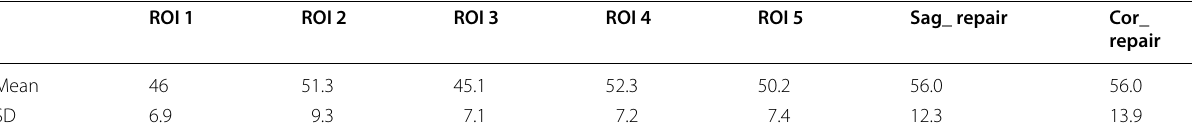
Mean T2 values with corresponding standard deviations (SD) for native and repair tissue. Mean values for each region of interest (ROI) are calculated from the first measurements of all observers and from averaging all 3 sub-regions in each ROI. ROI 1 and 2: sagittal plane, medial and lateral condyles, respectively. ROI 3: mid- sagittal, patella. ROI 4 and 5: coronal plane, medial and lateral condyles, respectively. Sag_repair and Cor_repair: mean sub-regional values for repair tissue on sagittal and coronal images, respectively